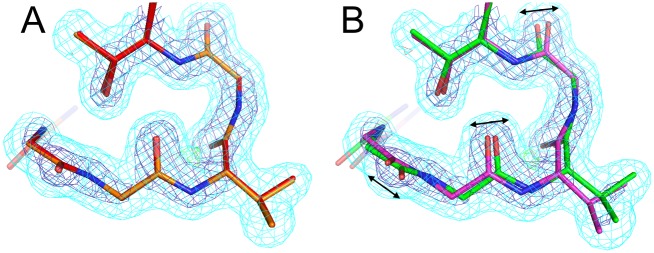
qFit 2.0 identifies alternative glycine conformations.This small loop in the 1.69 Å structure of Hyp–1 protein from St. John’s wort (PDB ID 3ie5) includes several glycines: 49, 50, and 52. (A) The deposited structure (orange) depicts these glycines with single conformations. The qFit 1.0 model (red) does the same, because it cannot sample alternative glycine conformations. (B) The qFit 2.0 model identifies alternative conformations (green/purple) for the entire loop, including all three glycines, based on subtly anisotropic backbone O atoms (arrows). 2mFo-DFc electron density contoured at 1.0 σ (cyan) and 3.0 σ (blue); mFo-DFc electron density contoured at +3.0 σ (green) and -3.0 σ (red).